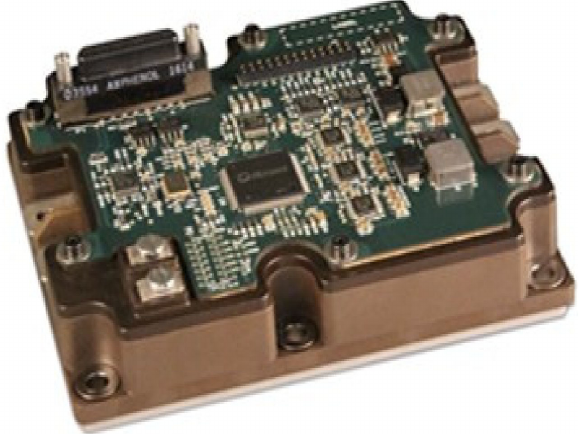
Figure 22. Power Core Module with SiC Power